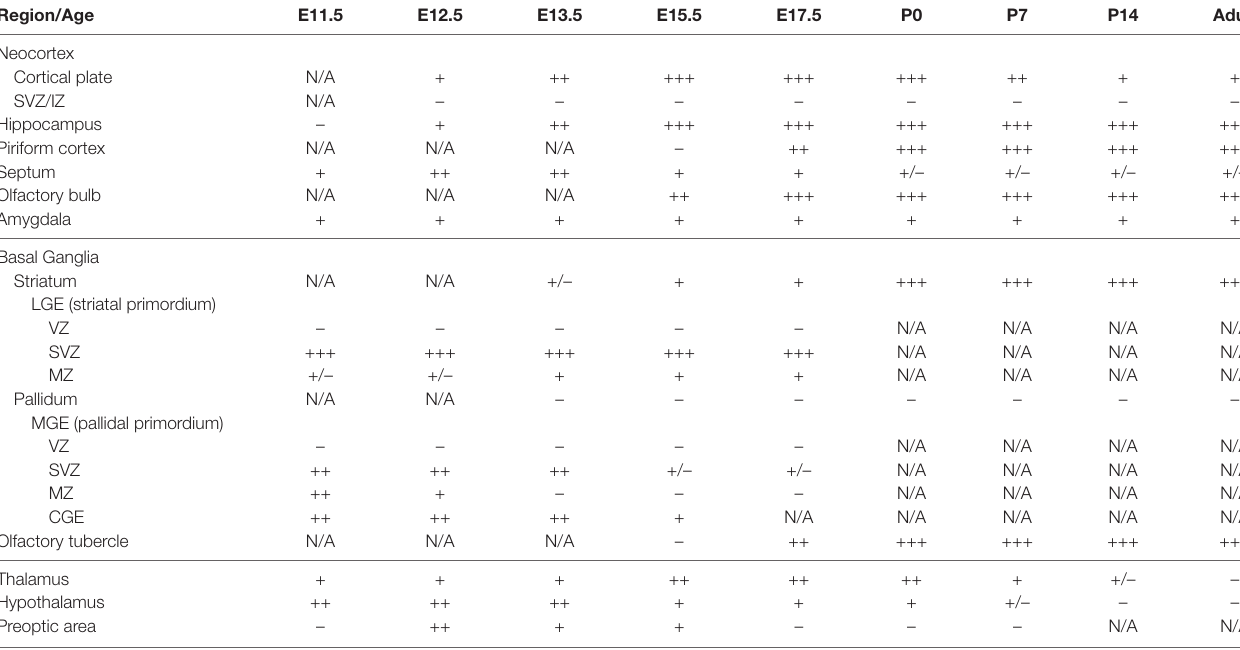
TABLE 1 | Expression pattern of Zswim6 in the developing mouse forebrain.